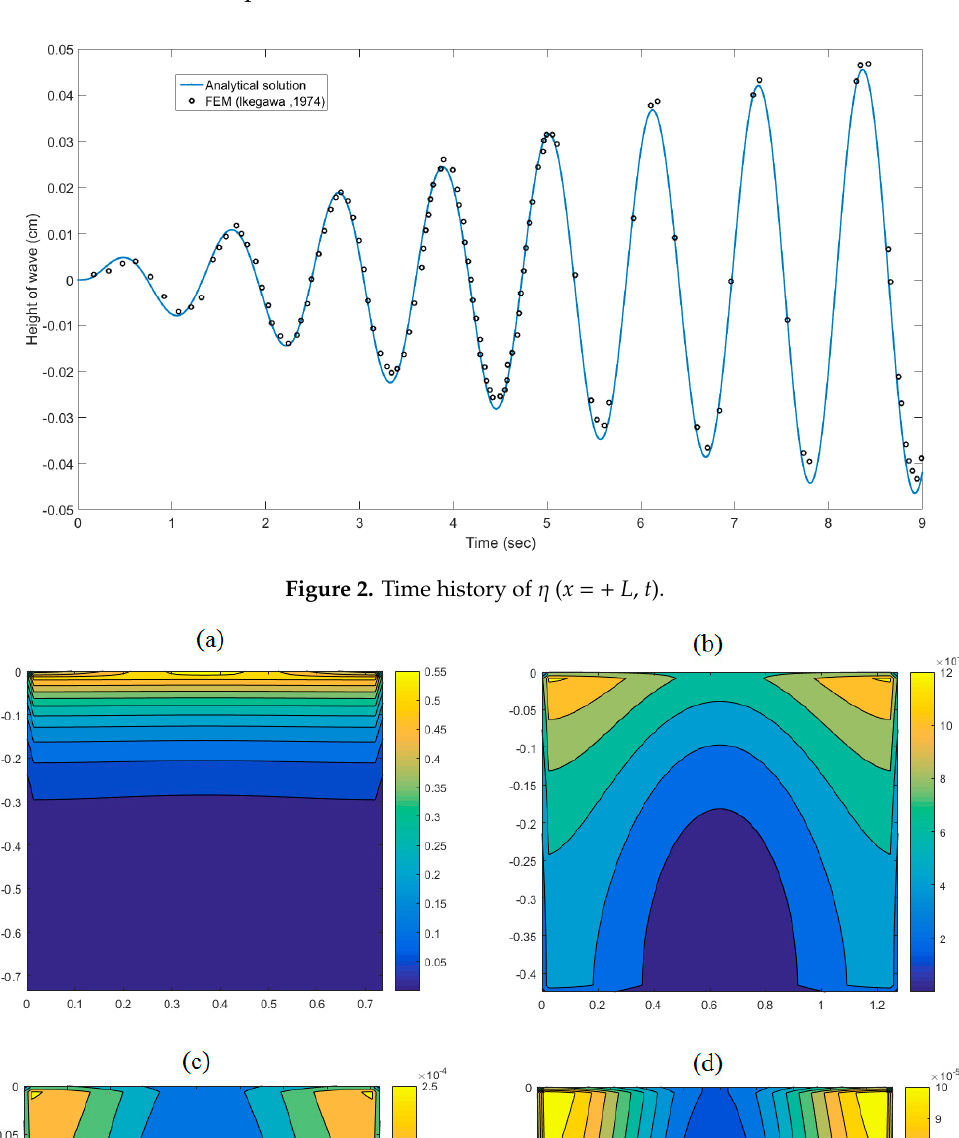
Figure 3. Distribution of dimensionless entropy generation for various aspect ratios ( a ) α = 1, ( b ) α = 3, ( c ) α = 5, and ( d ) α = 7.